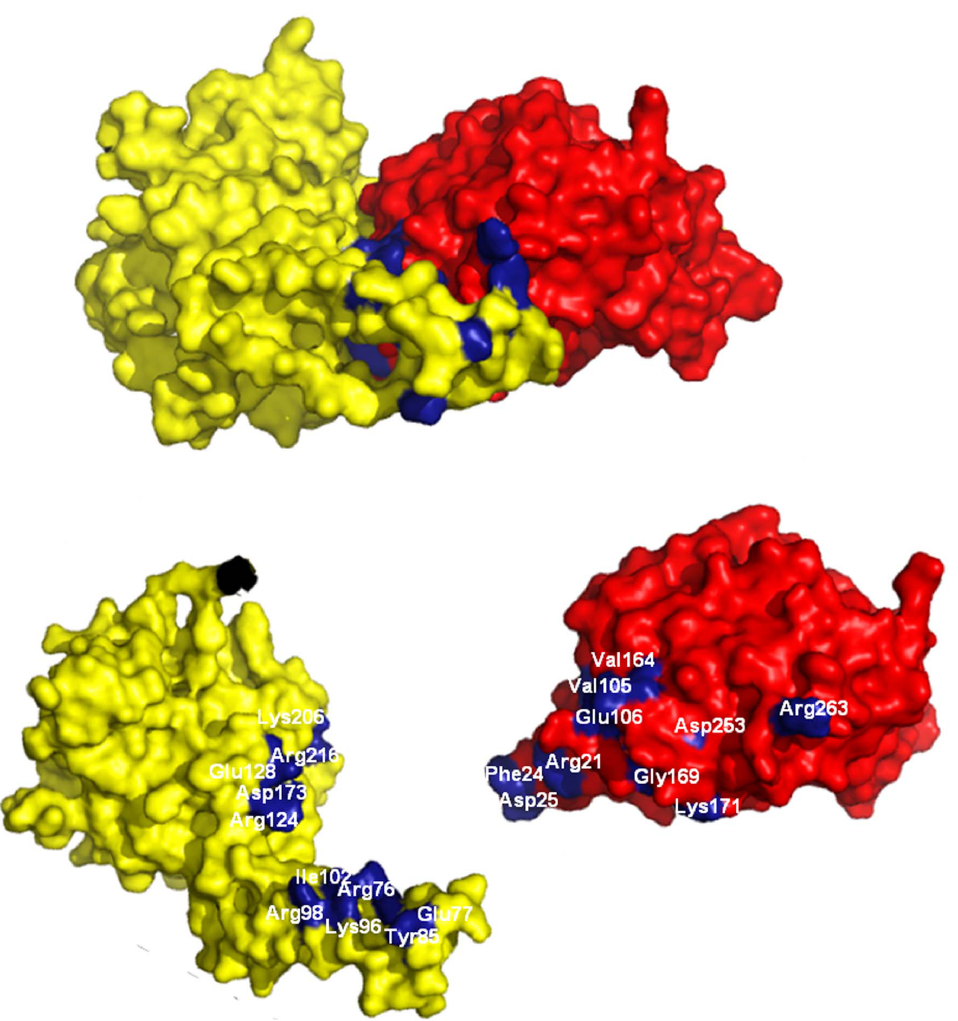
Figure 9. Surface representation of AD:ADL heterodimer, as obtained by ClusPro 2.0. Surface representation of the L. donovani AD-ADL heterodimer complex with AD (yellow) and ADL (red). Both monomers and the residues involved in heterodimer complex formation are shown below. The interaction is stabilized by salt bridges between Lys96, Arg124, Asp173, Lys206 and Arg216 of L. donovani AD with Asp253, Glu106, Arg21, Asp25 and Asp25 of L. donovani